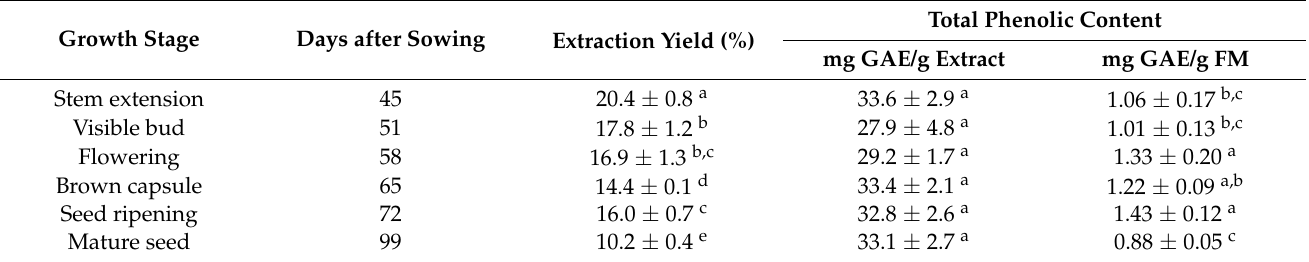
Table 1. Extraction yield and total phenolic content of the extracts and fresh matter (FM) of flax harvested at different growth